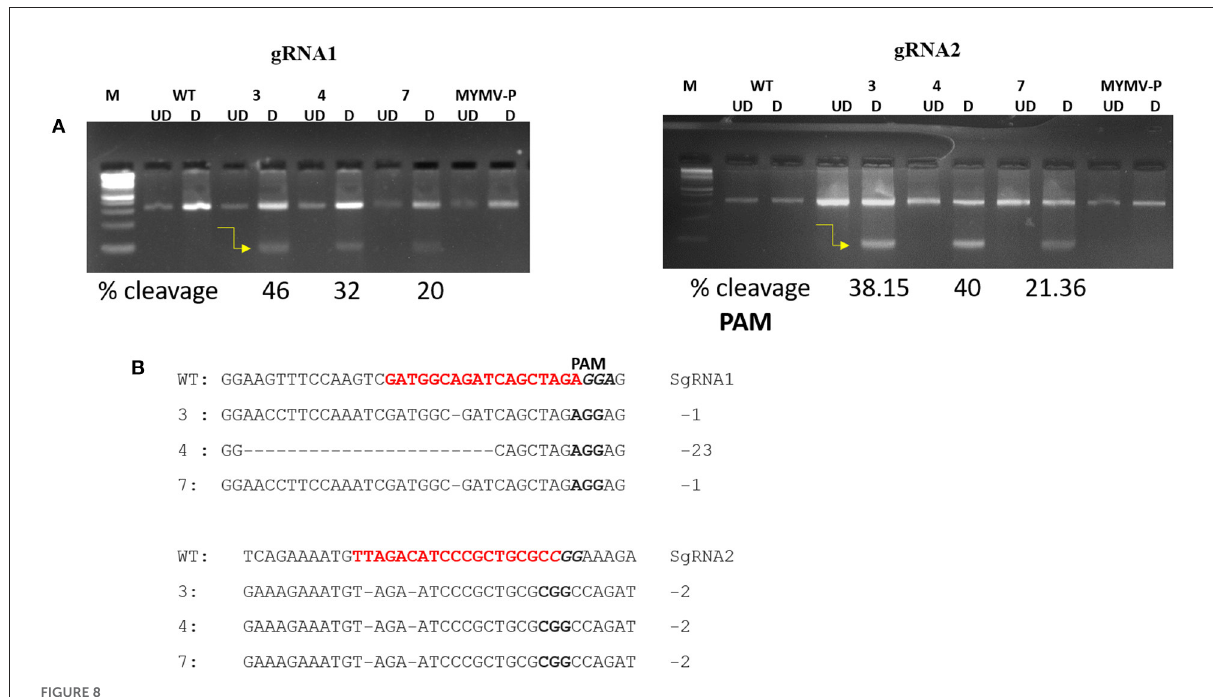
FIGURE8 Detection of genome editing by T7EI mutation analysis (A) Detection of mutations and transgenes in three T 2 transgenic lines. The PCR products of the MYMV region covering AC1 and AV1 sgRNAs were subjected to T7EI and resolved on 3% agarose gels. The arrow represents the DNA band of the T7EI cleavage products of T 2 -6-2-3 (46%), T 2 -6-4-4 (32%), T 2 -6-4-7 (20%) for gRNA1(AC1), and T 2 -6-2-3 (38.15%), T 2 -6-4-4 (40%), T 2 -6-4-7 (21.36%) for gRNA2 (AV1) ratio of editing. (B) A single base pair/heterozygous mutation was seen in sgRNA1 of T 2 -6-2-3, T 2 -6-4-7, and T 2 -6-4-4 having 23 base pair mutation, sgRNA1 target shown in red, whereas in sgRNA2, two base pair mutation was detected in all T 2 -6-2-3, T 2 -6-4-4 and T 2 -6-4-7, sgRNA2 target shown in